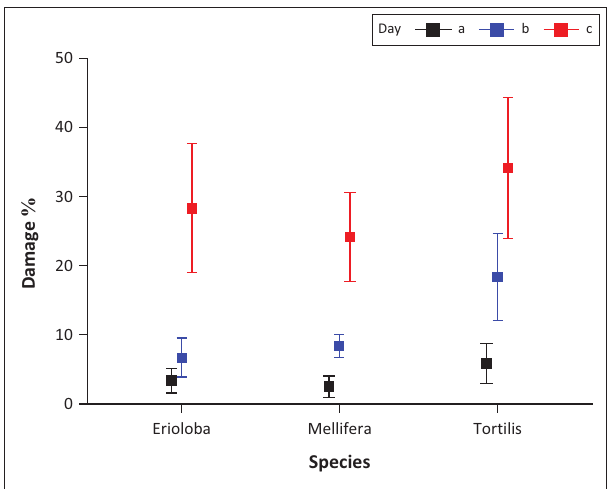
FIGURE 2: Growth reduction (% damage) calculated across a range of tebuthiuron concentrations that were established in soil collected from site Puntberg in an area which did not have a history of tebuthiuron application. Observations for which data are presented here were made 14 days after treatment (14 DAT –‘Day a’), 28 DAT (‘Day b’) and 56 DAT (‘Day c’) (Erioloba – Vachellia erioloba , Mellifera – Senegalia mellifera, Tortilis – Vachellia tortilis